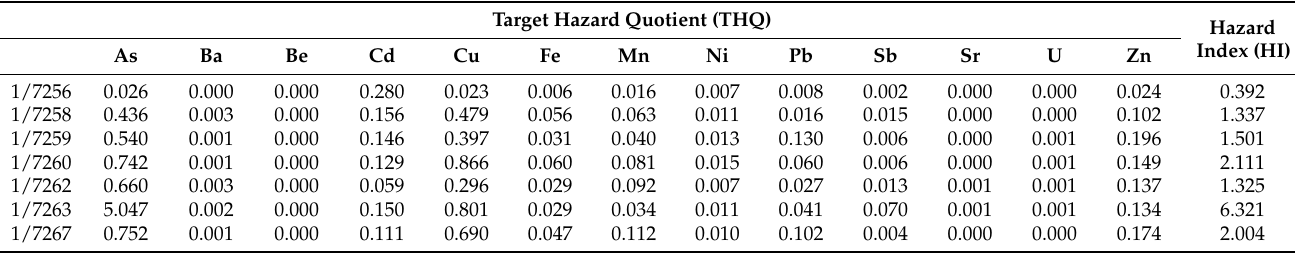
Table 6. Non-carcinogenic risk data (expressed by health risk indexes THQ and HI) obtained in the health risk assessment of metals through the consumption of the edible wild mushrooms from Croatia. The RfD data are expressed as µ g kg − 1 day − 1